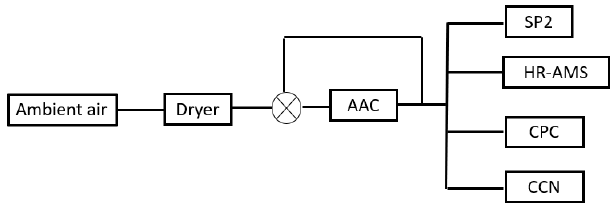
Figure 1. The schematic of the instruments setup. A timed three- way valve was placed upstream of the